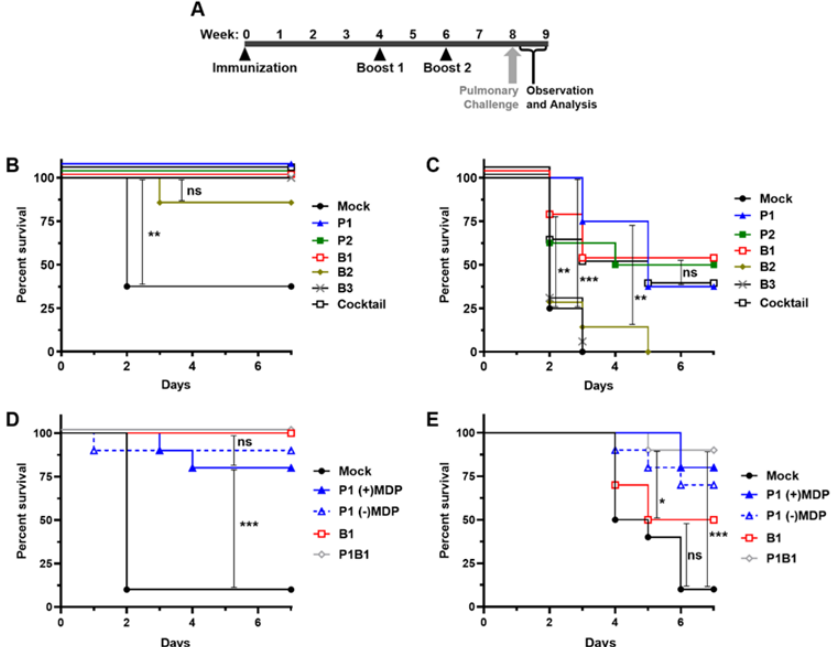
Figure 5. Immunization and intranasal challenge of mice with A. baumannii . ( A ) Graphic representation of the vaccination schedule. Mice were immunized at weeks 0, 4, and 6. Mice were challenged intranasally at week 8 and monitored daily until the end of week 9. ( B – E ) Kaplan–Meier Survival Analysis of vaccinated, or mock vaccinated mice challenged with AB5075 via intranasal inoculation as detailed in A. Panels B and C show groups of 8 mice immunized with candidate vaccines as indicated. B Shows survival in a healthy C57BL/6 mouse model, C shows survival in a neutropenic BALB/c model. Panels D and E show a second round of experiments using groups of 10 mice in the healthy C57BL/6 and neutropenic BALB/c models respectively. Log-rank (Mantle–Cox) test results of significance between survival numbers of groups is indicated by ns (not significant, p > 0.05), * p < 0.05, ** p < 0.01, and *** p < 0.001.